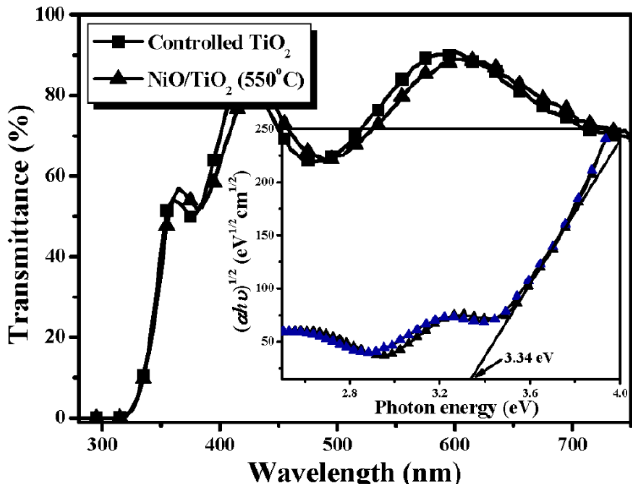
Figure 4. Optical transmittance of the controlled TiO 2 film and the NiO/TiO 2 nanocomposite structure annealed at 550 °C (the associated optical energy bandgaps also are derived from the inset figure).